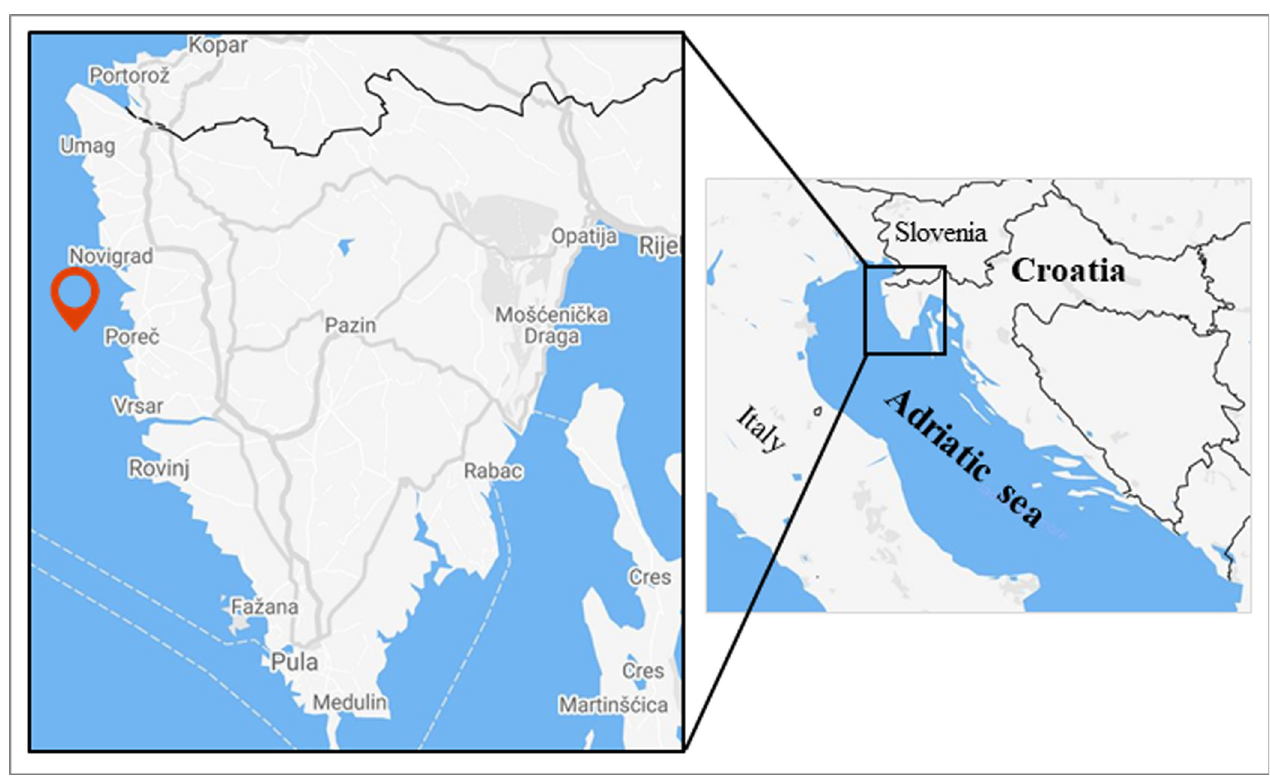
Fig 1. Map of the area. The label indicates the approximate location of the P . jacobaeus sampling, and the location of sea temperature, salinity and dissolved oxygen measurements.